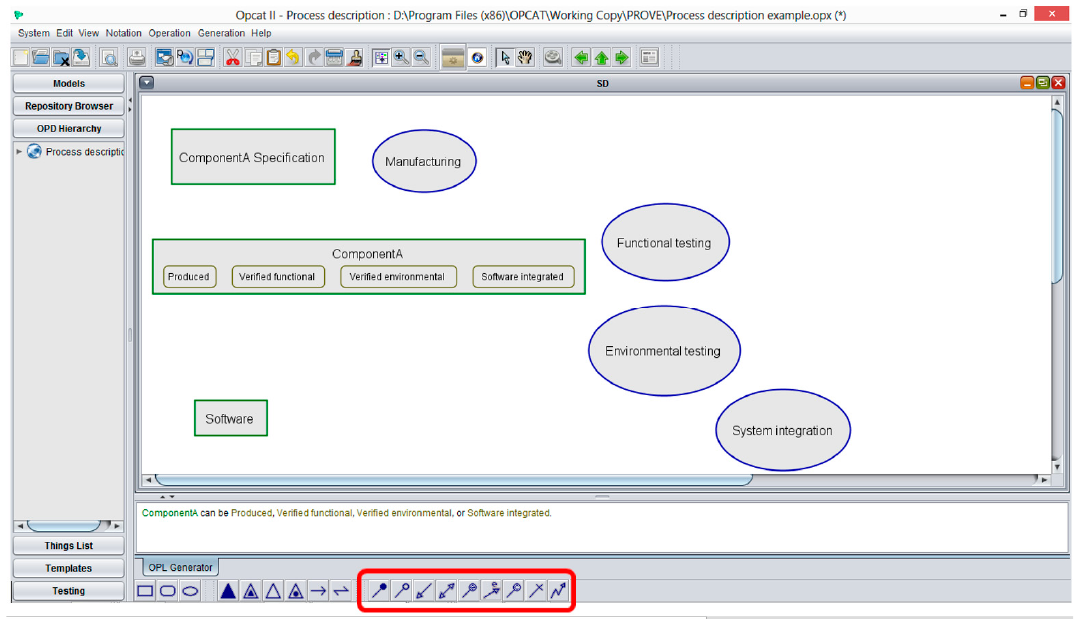
Figure 1. OPM diagram in OPCAT modeling tool, after adding object, process, and state elements.